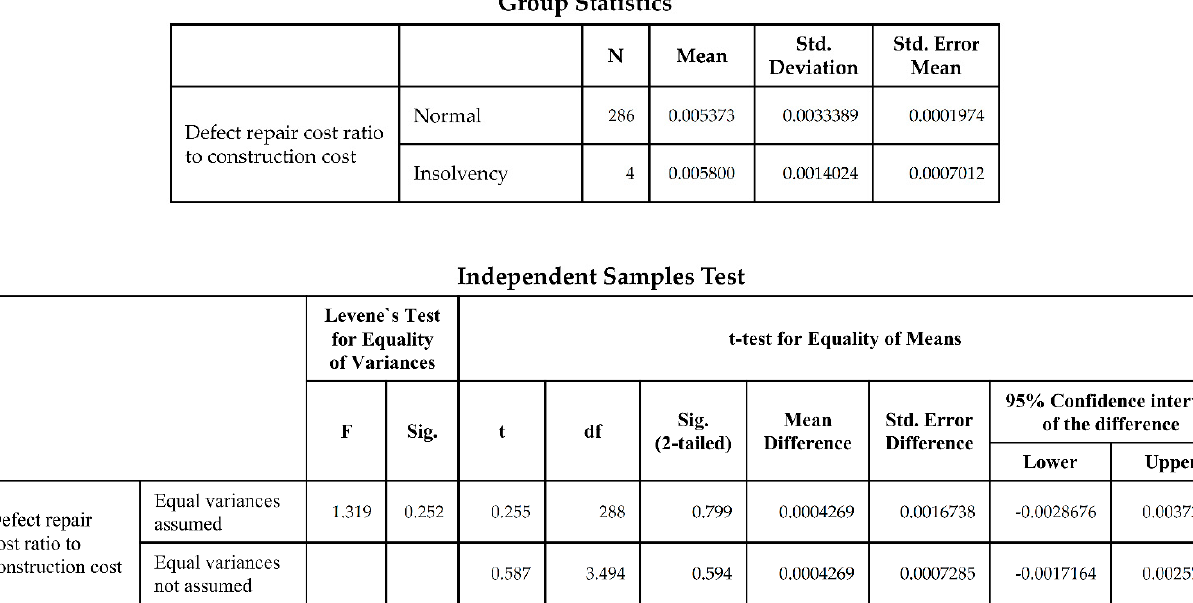
Figure A7. t ‐ test result of builder’s insolvency.